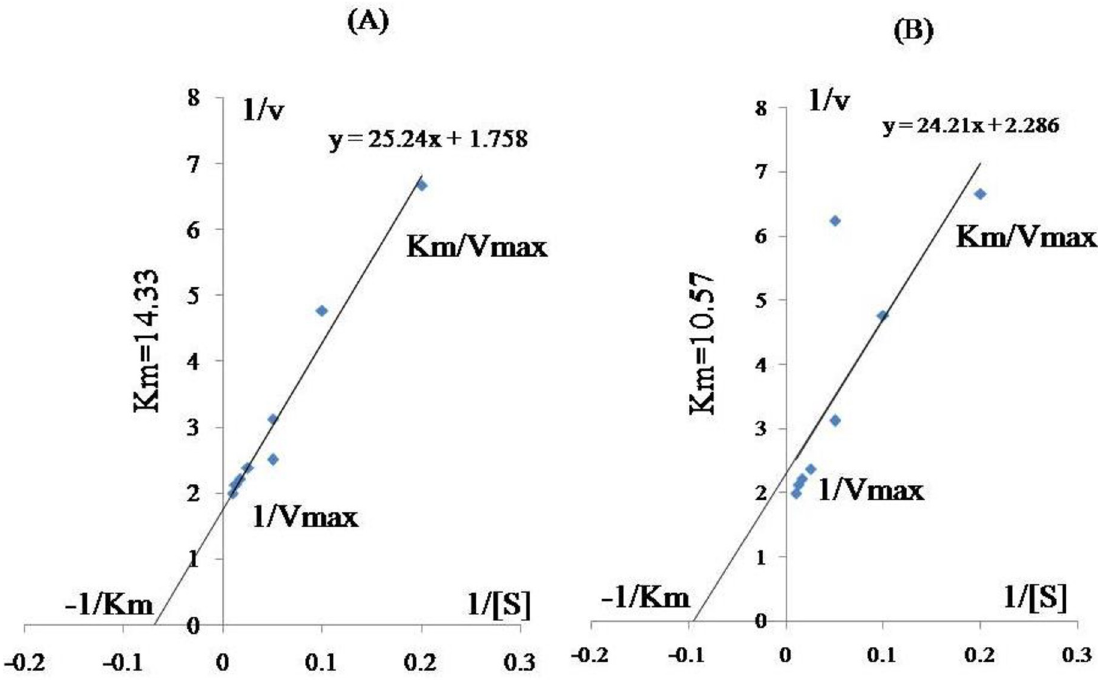
Fig 2. Lineweaver-Burke plot of laccase in bacterial isolate 2D (plot A and B). Plot A shows laccase activity under normal condition while plot B shows laccase activity in minimal medium with